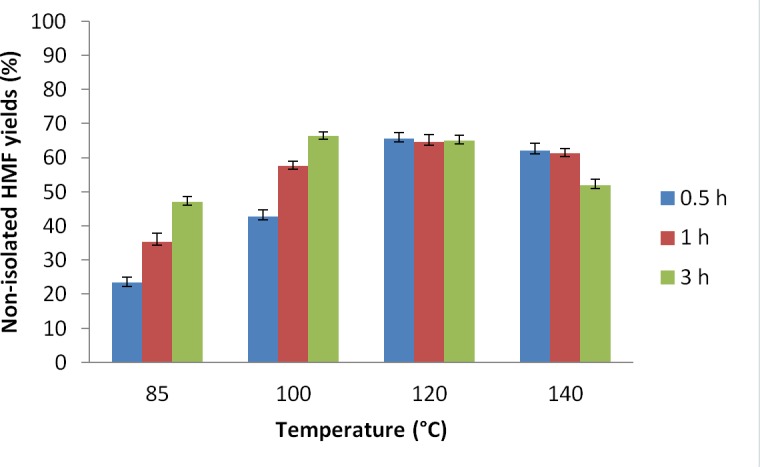
Yield of HMF from glucose as a function of reaction temperature from 85–140°C.0.1 g glucose in 0.7 g [C4C1im]Cl, 7 mol% CrCl3·6H2O catalyst. Yields shown are not isolated. The lines are included solely as an aid to guide the eye.